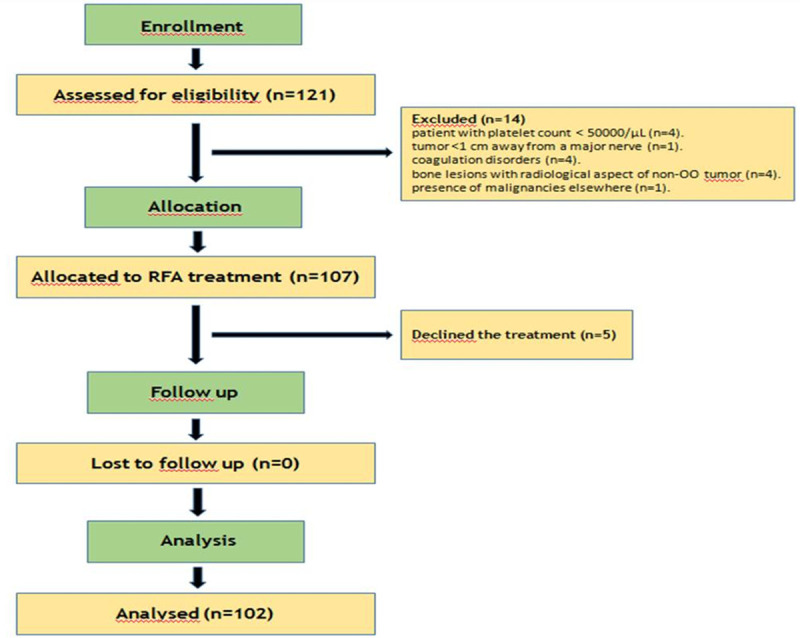
Consort flow chart.